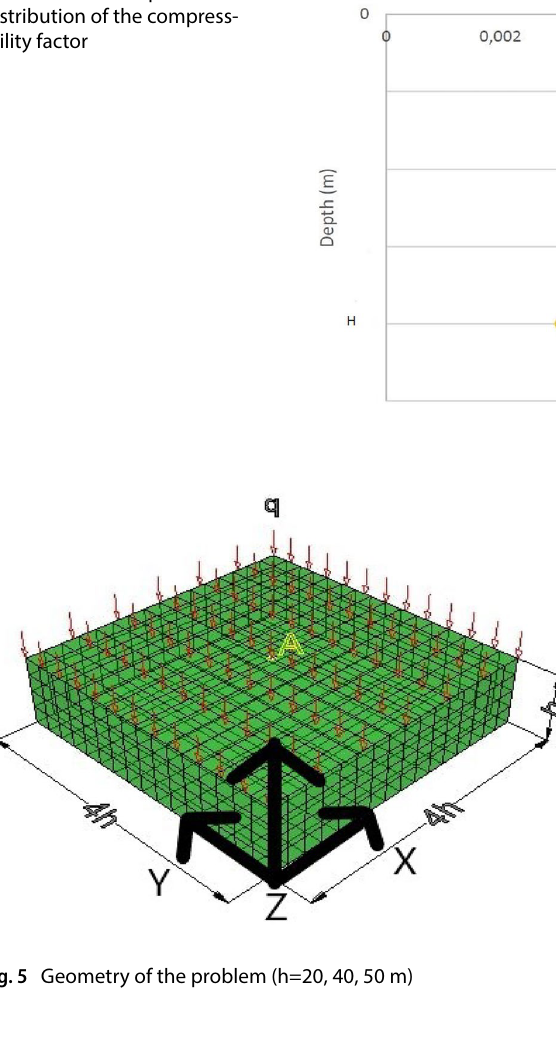
Fig. 4 Graphical representa- tion for the linear spatial distribution of the compress- ibility factor